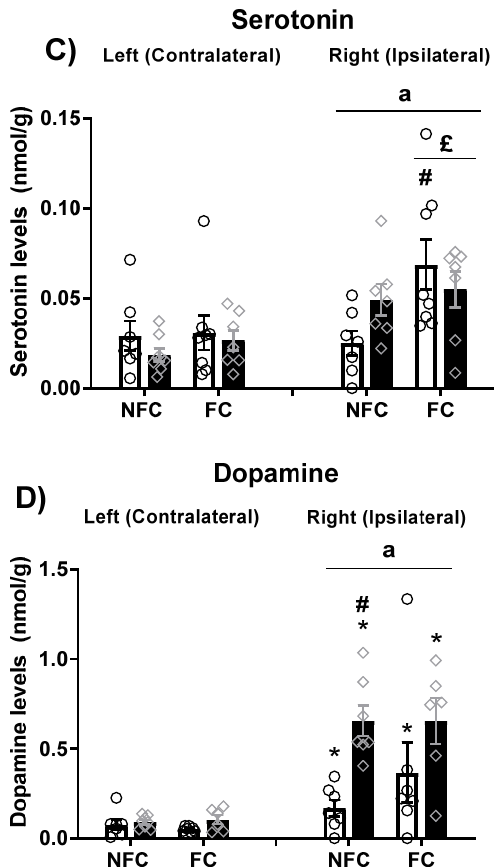
Figure 17. Effects of fear-conditioning and intraplantar injection of formalin on the levels of GABA ( A ), glutamate ( B ), serotonin ( C ), and dopamine ( D ). Two-way ANOVA revealed a significant effect of side on all neurotransmitters ( a p < 0.05). Post hoc pairwise analysis with Student Newman–Keuls showed a significant difference in serotonin levels between the NFC Vehicle and FC Vehicle of i.pl. saline-treated rats ( # p < 0.05), and dopamine levels between the NFC Vehicle i.pl. saline-treated and NFC Vehicle i.pl. formalin-treated rats ( # p < 0.05). The test also confirmed side differences (* p < 0.05, compared to their left counterparts) in the dopamine levels. Data are expressed as mean ± S.E.M, each symbol represents one individual, ( n = 7–9 rats per group).